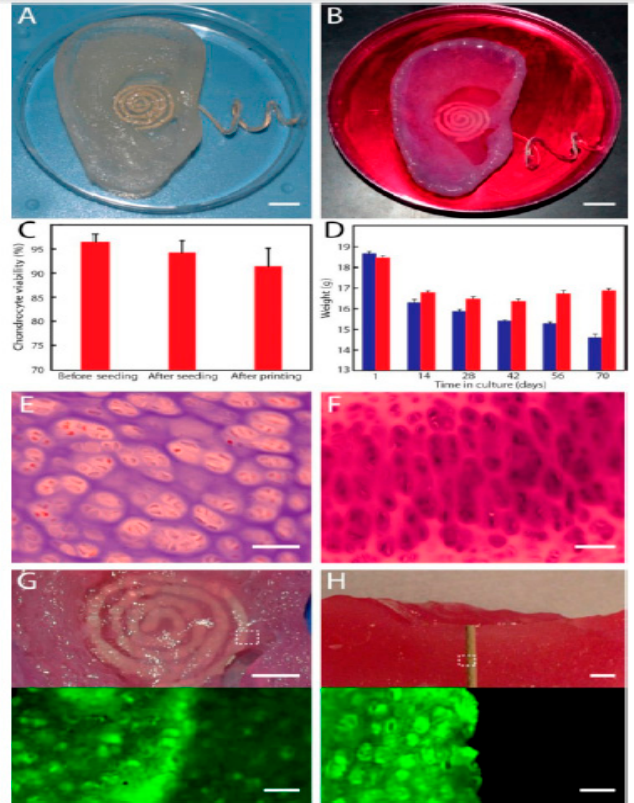
Figure 6. Image of the ( A ) fabricated 3D printed bionic ear and ( B ) 3D printed bionic ear during its vitro culture. ( C ) The viability of chondrocyte at different stages during the printing process. ( D ) Deviation of the weight of the printed ear over time in culture, where the ear consisted of the chondrocyte-seeded alginate or only alginate shown in red and blue colour respectively. ( E ) Histologic analysis of chondrocyte morphology done using H&E staining. ( F ) Neocartilaginous tissue being Safranin O stained after 10 weeks of culture. Photographs (top) and fluorescent (bottom) images of ( G ) viability of the neo cartilaginous tissue being in contact with the antenna of the coil and ( H ) cross-section of the bionic ear showing the viability of the internal cartilaginous tissue in contact with the electrode. Reproduced from Mannoor et al. [82] .